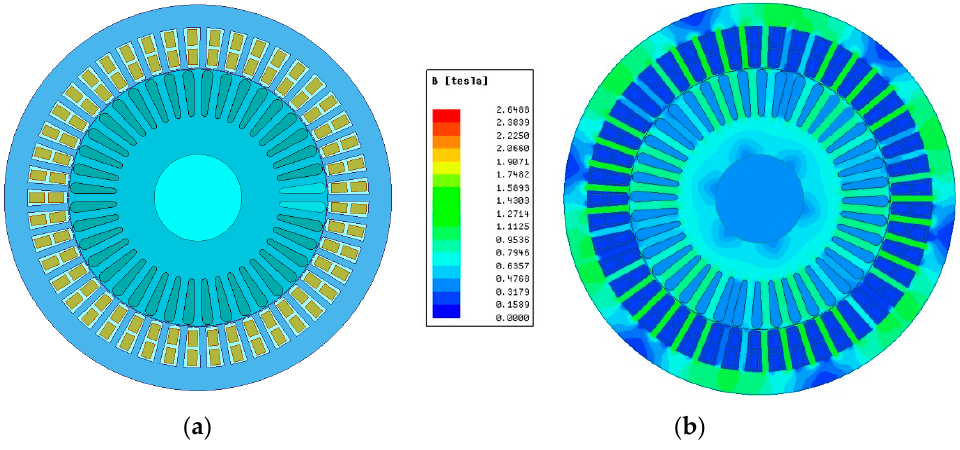
Figure 3. ( a ) RFIM model ( b ) Magnetic field density of RFIM.